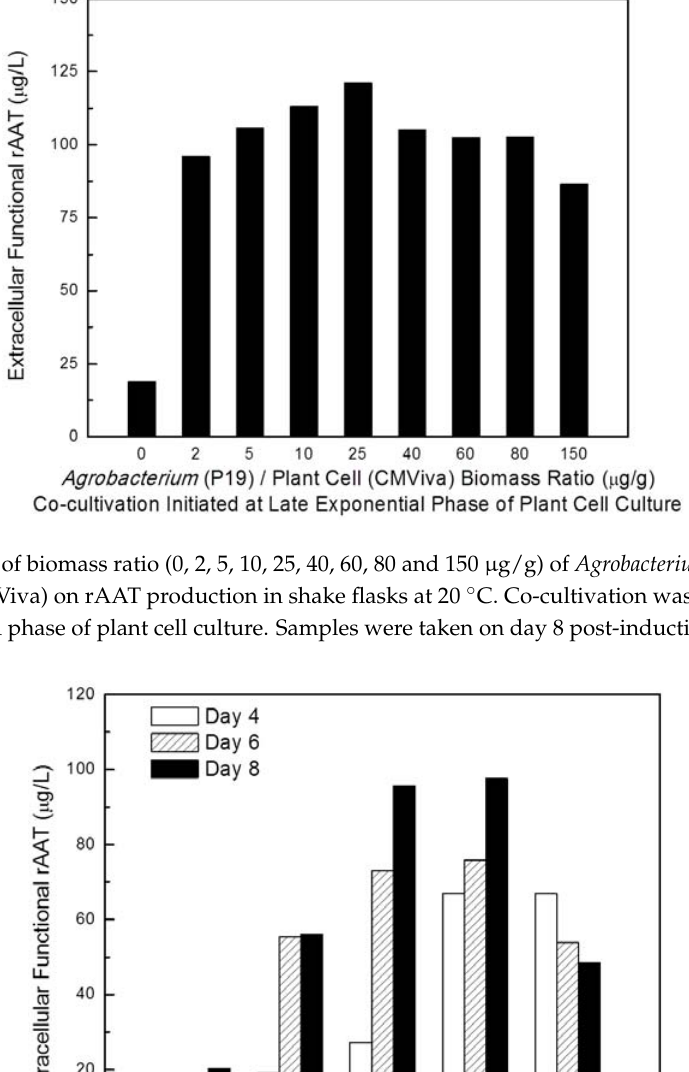
Figure 6. Effect of biomass ratio (0, 2, 5, 10, 25, 40, 60, 80 and 150 μ g/g) of Agrobacterium to transgenic plant cells (CMViva) on rAAT production in shake flasks at 20 °C. Co ‐ cultivation was initiated in the late exponential phase of plant cell culture. Samples were taken on day 8 post ‐ induction.